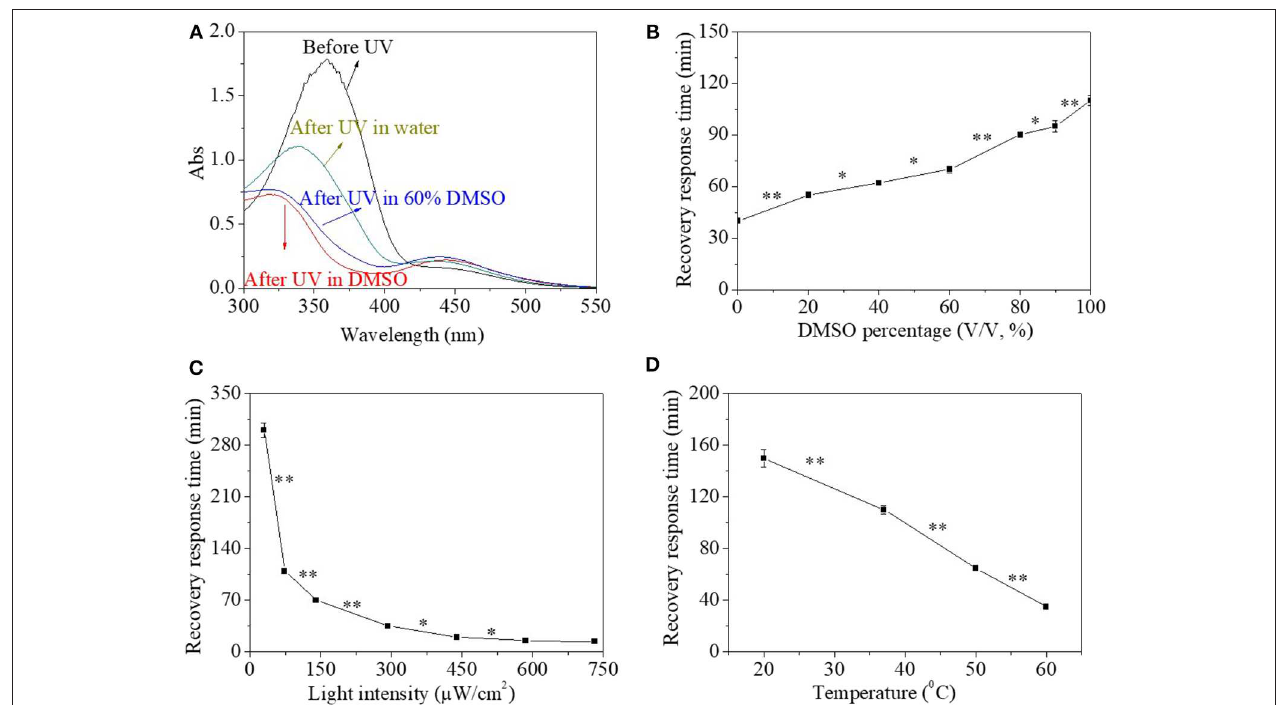
FIGURE 3 | (A) UV spectra of the HEMA-AZO copolymer before and after UV irradiation in dimethylsulfone (DMSO)/H 2 O solution. (B) The recovery–response time in DMSO/H 2 O solution as a function of DMSO percentage under 73 µ W/cm 2 white light at 20 ◦ C. The recovery–response time as a function of (C) light intensity at 20 ◦ C and (D) temperature under 65 µ W/cm 2 white light in DMSO solution. * p < 0.05, ** p < 0.01. p refers to significance level in the data set.